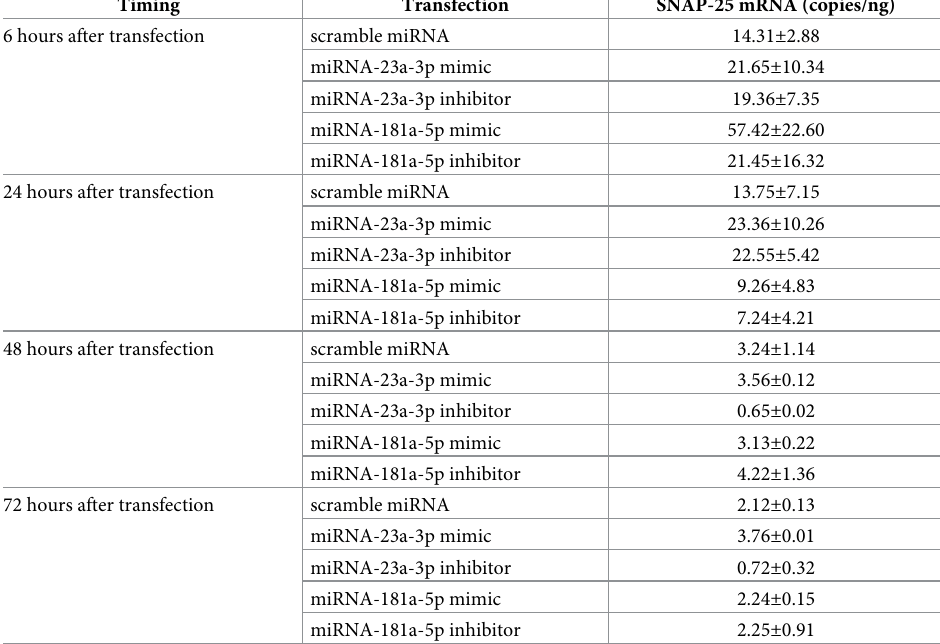
Table 1. SNAP-25 gene expression (copies/ng) in MO3.13 cells transfected with miR-23a-3p mimic, miR23a-3p inhibitor, miR-181a-5p mimic, miR-181a-5p inhibitor, and scramble negative miRNA. The SNAP-25 expression was measured in different time points: 6 hours after transfection, 24 hours after transfection, 48 hours after transfec- tion, and 72 hours after transfection. Data are expressed as mean ± standard